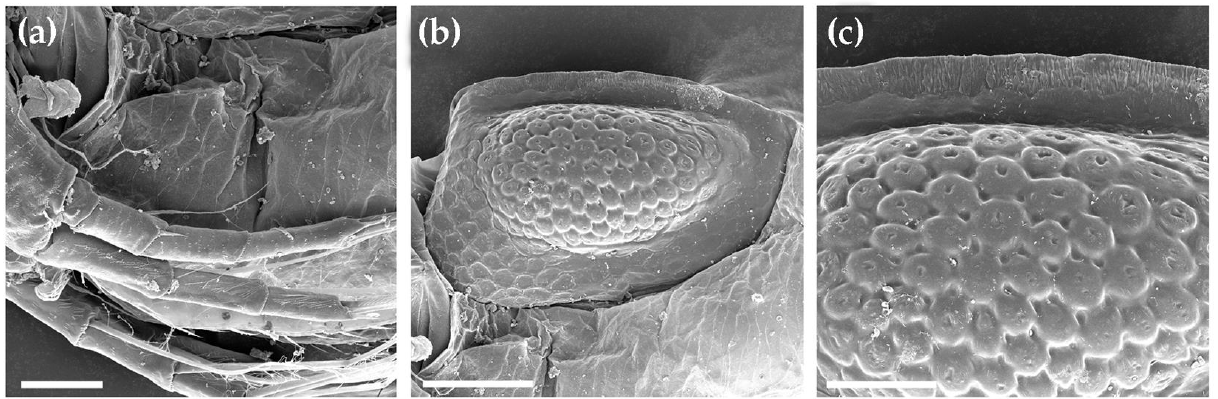
Figure 9. Moina cf. micrura , an ephippial female from Masfoot Dam 1, United Arab Emirates: ( a ) antenna II; ( b ) ephippium; ( c ) ornamentation of ephippium with higher magnification. Scale bars 0.1 mm for ( b ), 0.05 mm for ( a , c ).